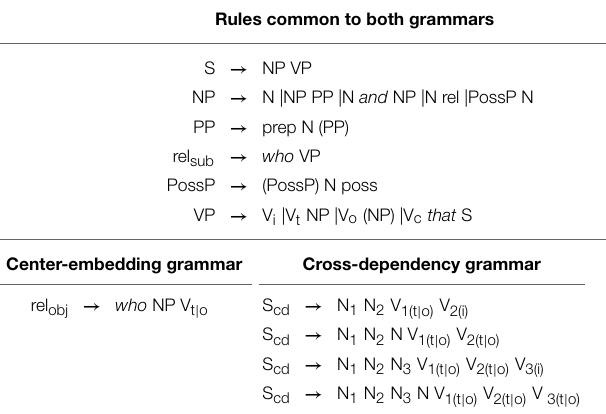
TABLE 4 | The grammars used by Christiansen and MacDonald